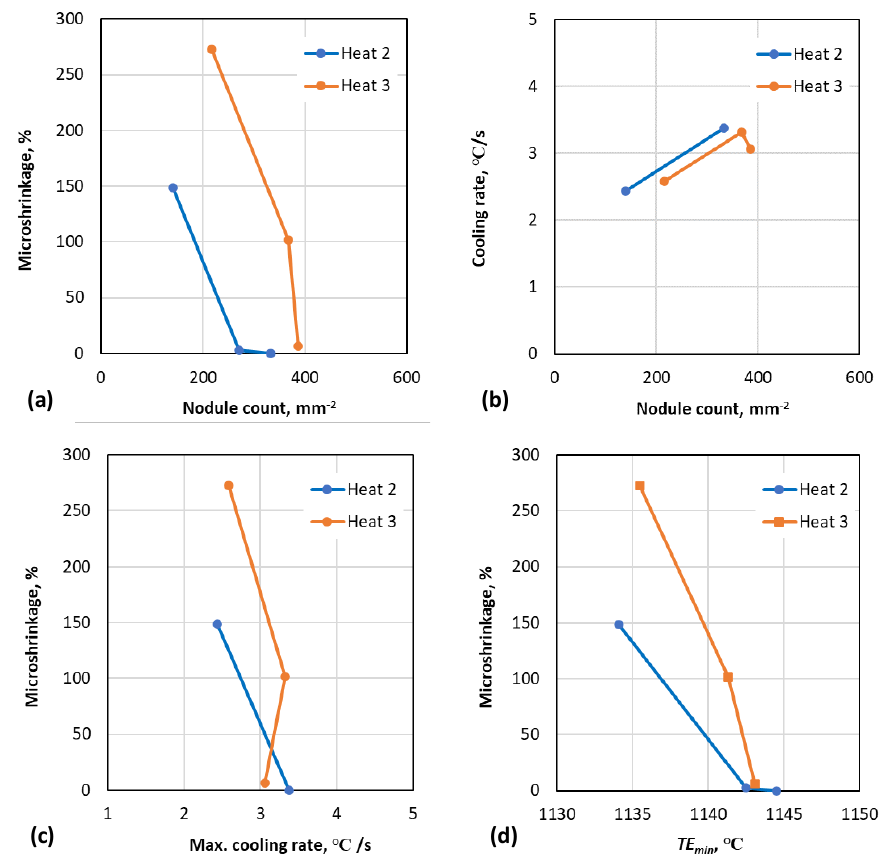
Figure 6. Correlation between various measured parameters and microshrinkage; the variable on the abscise reflects the sequential left-to-right change not inoculated-inoculated-inoculated + Se: ( a ) correlation between microshrinkage and nodule count; ( b ) correlation between nodule count and cooling rate; ( c ) correlation between microshrinkage and the maximum cooling rate; ( d ) correlation between microshrinkage and minimum eutectic temperature